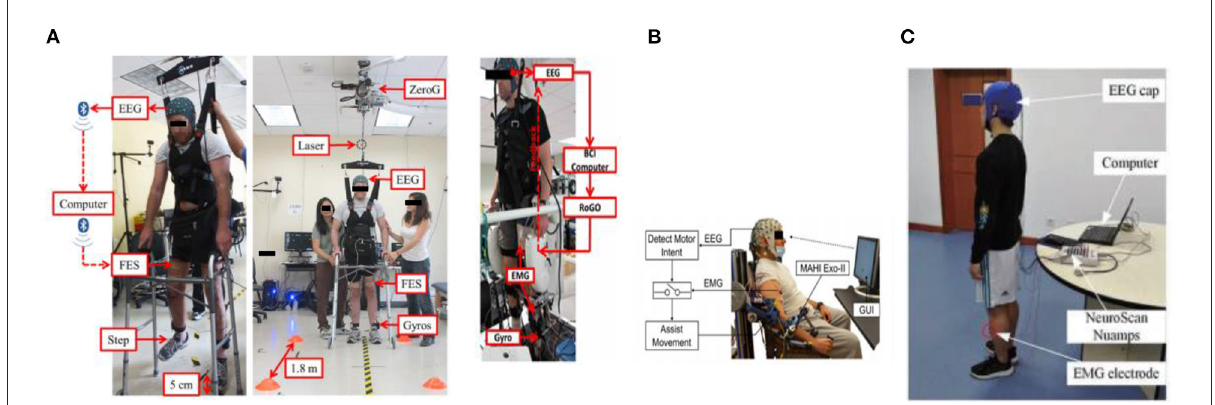
FIGURE10 Examples of robot control-based BCI (A) EEG-based BCI to control a functional electrical stimulation (FES) system for overground walking (King et al., 2015). (B) BCI-robotic gait orthosis (RoGO) and BMI control task (Do et al., 2013). (C) EEG electrode position based on the international standard 10–20 system experimental scene (Li H. et al.,